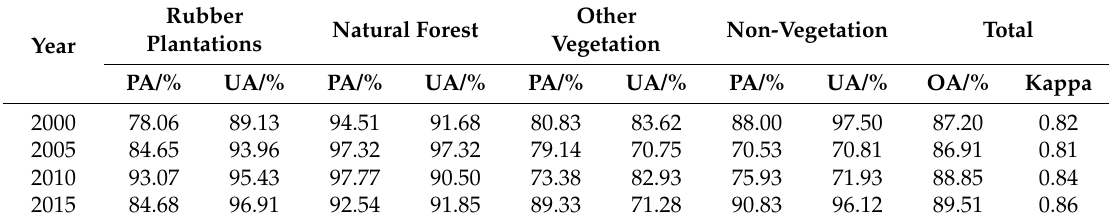
Table 11. Classification accuracies in 2000, 2005, 2010, and 2015 .